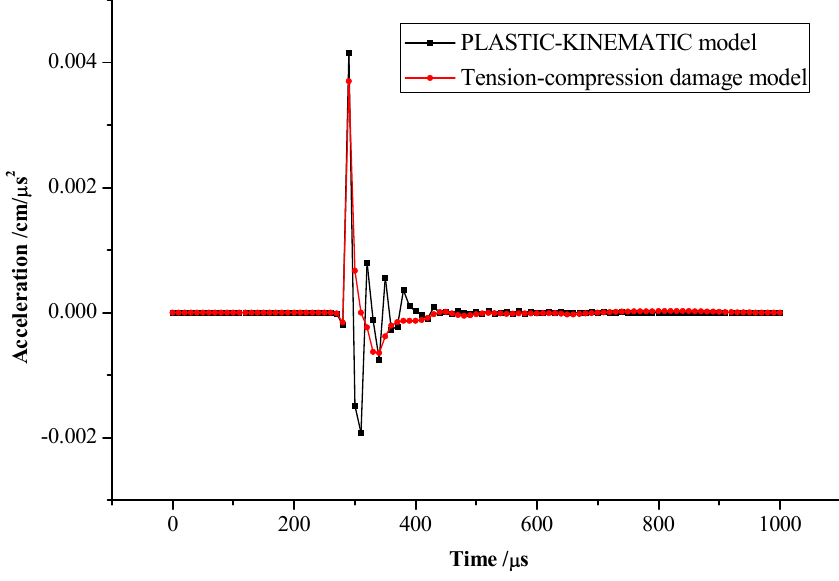
Figure 5. Acceleration–time curves for monitoring point 1.